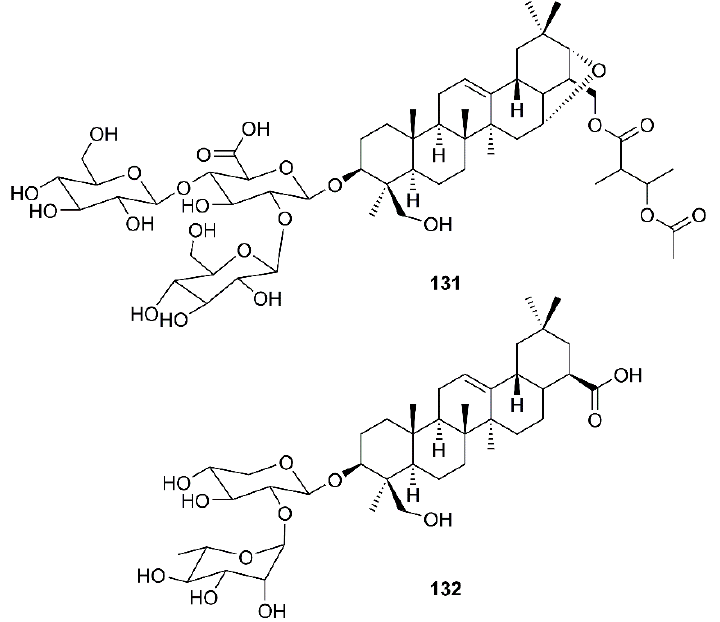
Figure 20. Structures of triterpene glycosides aescin ( 131 ) and α -hederin ( 132 ).